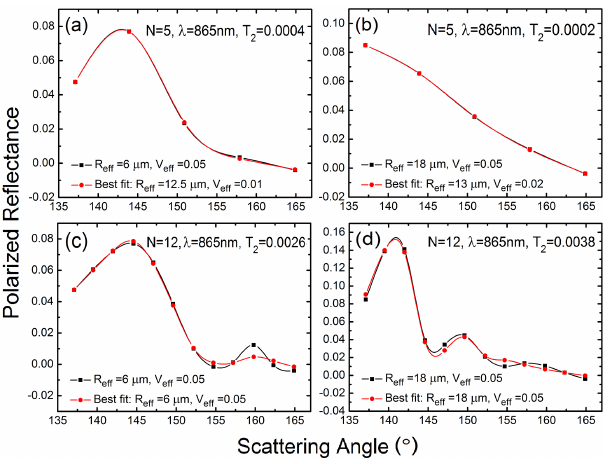
Figure 5. Comparisons of the observed rainbow structure and best fit curves when N = 5 and N = 12. The black and red points are the model (POLDER-like) and best fit reflectances, respectively. The COT was assumed to be 5 in all